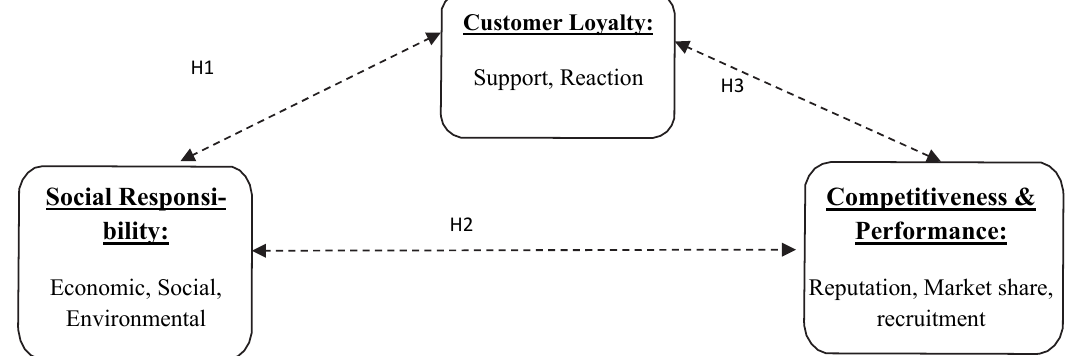
Fig. 1. Conceptual model: Social Responsibility, Customer loyalty and